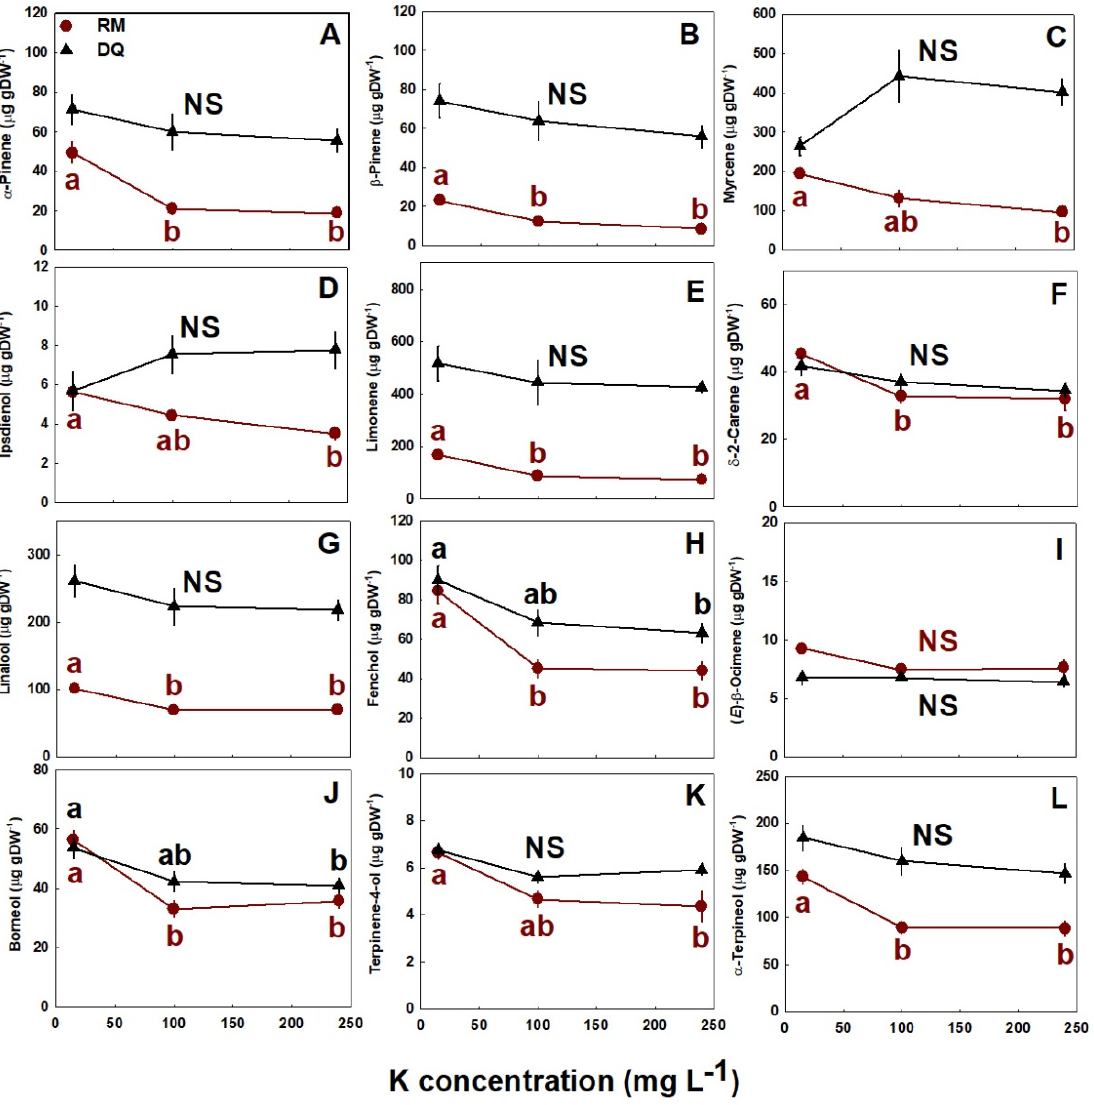
Figure 5. Effect of K supply on monoterpene concentration in the medical cannabis cultivars RM and DQ at the top (primary) inflorescence. α -Pinene ( A ), β -pinene ( B ), myrcene ( C ), ipsdienol ( D ), limonene ( E ), δ -2-carene ( F ), linalool ( G ), fenchol ( H ), ( E )- β -ocimene ( I ), borneol ( J ), terpinene-4-ol. ( K ) and α -terpineol ( L ). Presented data are averages ± SE ( n = 5). In the one-way ANOVA results, NS signifies no significant differences between treatments, and different small letters signify significant differences between treatments by Tukey’s HSD test at α = 0.05.